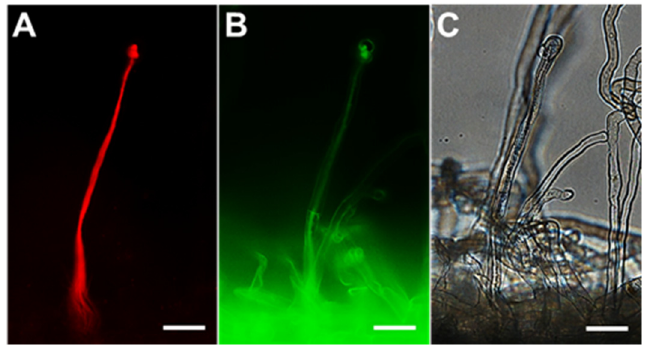
Figure 3. Detection of reactive sulfur species during infection. ( A ) Infection thread produced by Mesorhizobium loti MAFF303099 DsRed. ( B ) Polysulfide detected by using the specific probe SSP4. ( C ) Bright field observation. L. japonicus B-129 was used as a host plant. Scale bars, 25 μ m.